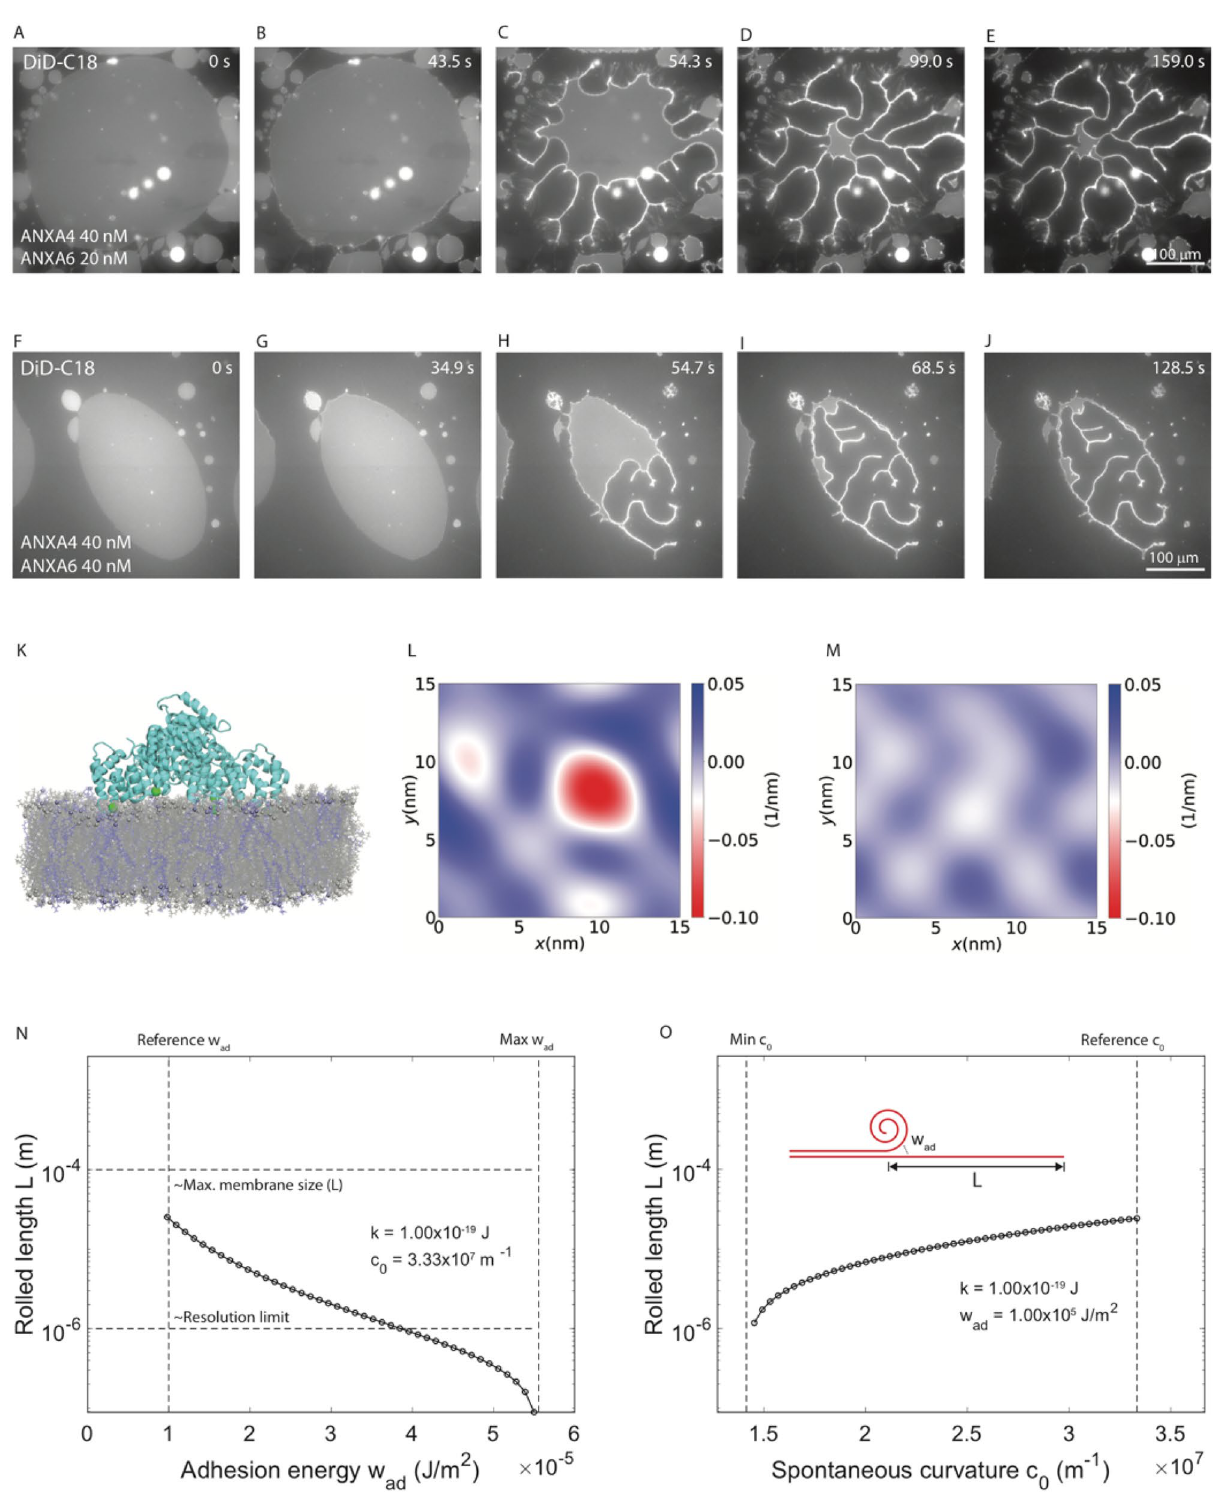
Figure 2. Incomplete rolling of membrane patches in the presence of ANXA4 and ANXA6 mixtures. Response of non-vesicular membrane patches with open edges (DOPC/DOPS, 9:1 molar ratio) to exposure to a mixture of 40 nM ANXA4 with 20 nM ( A – E ) and 40 nM ( F – J ) ANXA6. Molecular dynamics simulation of ANXA6 with membrane. ( K ) Final simulation snapshot. POPC lipids are shown in grey and POPS lipids are in blue. Ca 2+ ions are shown as green spheres ( L ) Curvature profile for a surface passing through the center of the membrane with ANXA6 ( M ) Curvature profile for a surface passing through the center of the membrane without ANXA6. Theoretical modelling of the rolled membrane length L ( N , O ). Change in the rolled length L as a function of an increase in the adhesion energy w ad relative to the reference value ( N ). Change in the rolled length L as a function of a reduction in spontaneous curvature c 0 relative to the reference value ( O ). Images prepared using NIS elements, version 5.10 (https:// www. micro scope. healt hcare. nikon. com/ produ cts/ softw are/ nis- eleme nts) and Visual Molecular Dynamics, version 1.9.3 (https:// www. ks. uiuc. edu/ Resea rch/